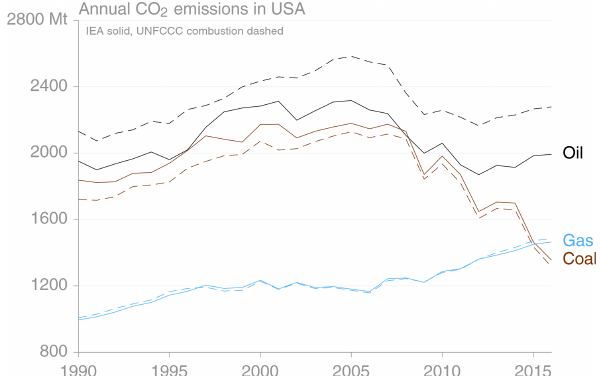
Figure 9. Comparison of emissions estimates for the USA from the IEA and